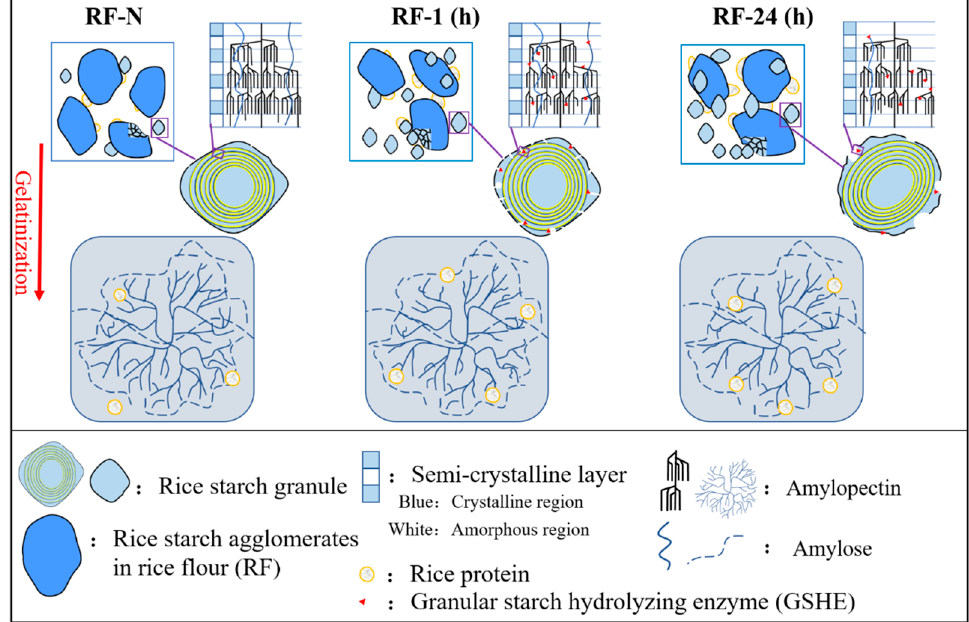
Figure 7. The diagram of the hydrolytic mechanism of GSHE on RF .